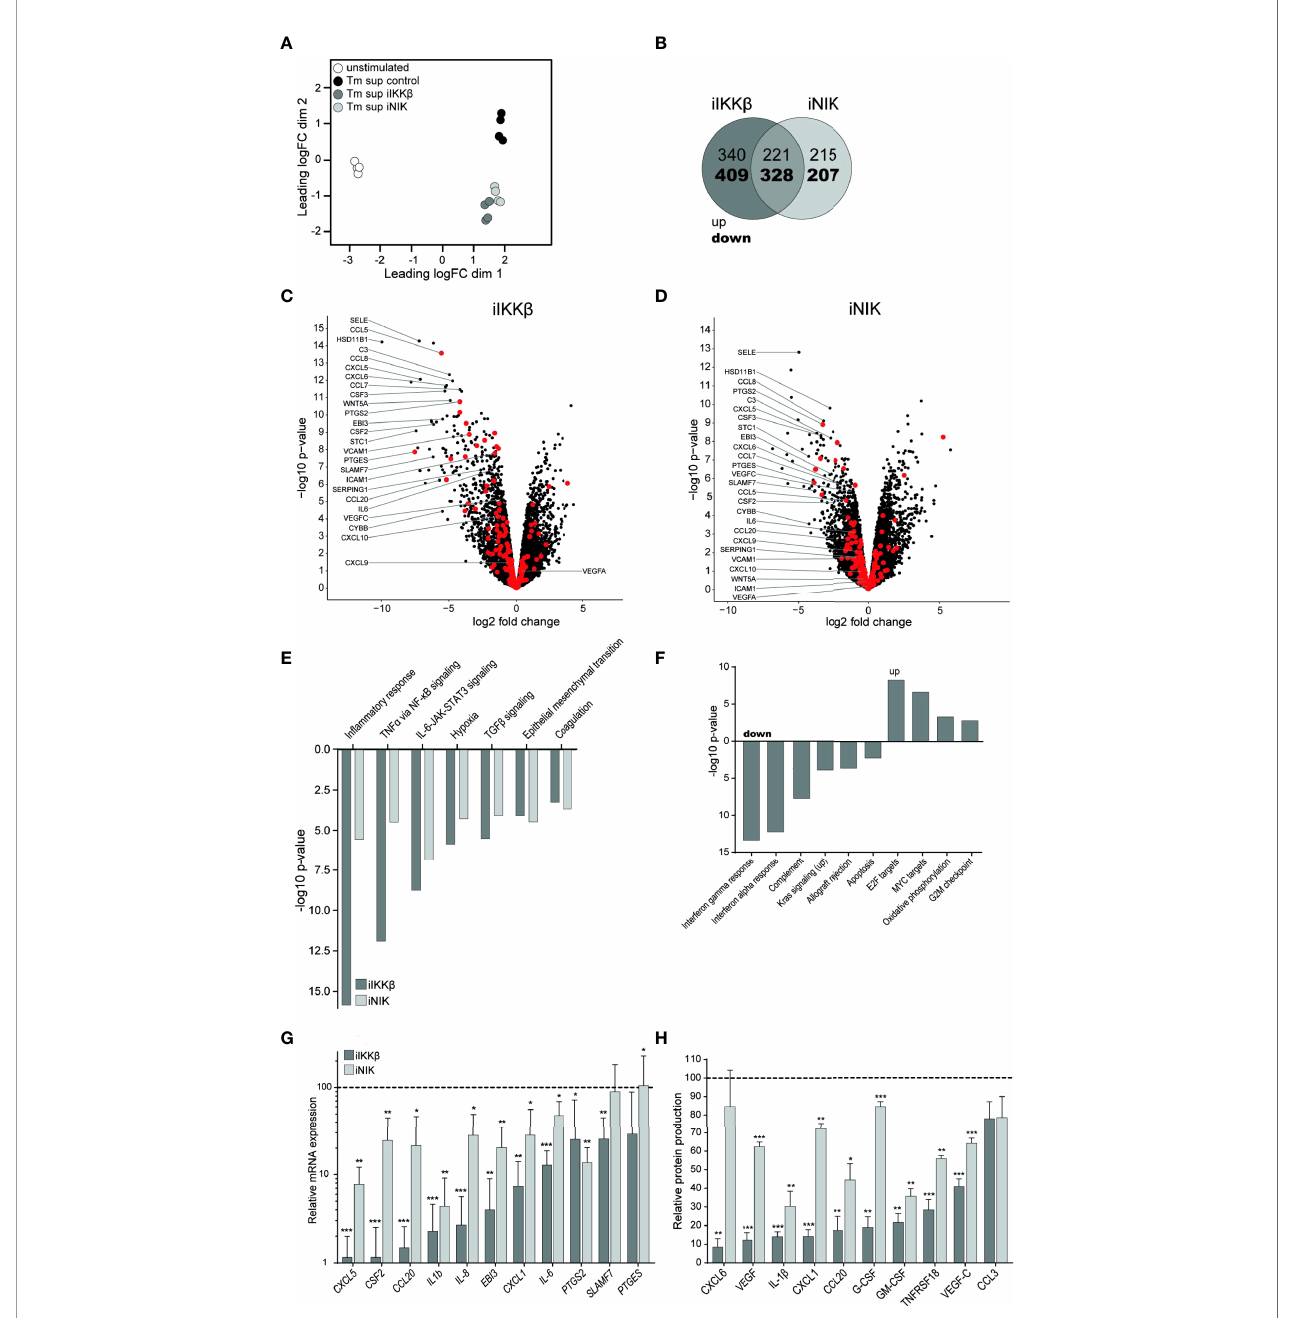
FIGURE 4 | Treatment with NF- k B inhibitors reduces EC in fl ammatory activation. RNA sequencing was performed on ECs after 72h of T m stimulation and treatment with iIKK b or iNIK. (A) Clustering of different RNA sequencing conditions. Multi-dimensional scaling of transcriptomes based on top 500 genes in unstimulated (white), T m stimulated DMSO treated (control, black), T m stimulated 1.0 µM iIKK b treated (dark gray) and T m stimulated 2.5 µM iNIK treated (light gray) ECs ( n= 4). Each dot represents an individual sample. (B) Number of genes differentially expressed in T m sup stimulated ECs treated with iIKK b (dark gray), iNIK (light gray) or both (pink) compared to control (log2 fold change>1.0, p <0.05). (C, D) Volcano plot showing changes in gene expression in (C) T m stimulated iIKK b treated vs T m stimulated DMSO treated (control) ECs and (D) T m stimulated iNIK treated vs control ECs. Enrichment (x-axis, log2 fold change) is plotted against signi fi cance (y-axis, -log10 p -value). Selected genes are annotated and NF- k B associated genes are highlighted in red. (E, F) Analysis of Hallmark gene sets. (E) Differentially expressed (FDR ≤ 0.05, p<0.05) Hallmark gene sets in both T m stimulated iIKK b treated and iNIK treated ECs vs control ECs. (F) Hallmark gene sets exclusively affected in T m sup stimulated iIKK b treated ECs vs control ECs (FDR ≤ 0.05, p<0.05). For MYC targets, Hallmark gene set MYC targets V2 is shown, similar results were obtained for MYC targets V1 . RNA sequencing results were validated on a selection of pro-in fl ammatory cytokines, chemokines, growth factors and other in fl ammatory mediators on (G) mRNA level by qPCR and (H) protein level by Magnetic Luminex assay ( n= 5). Dark gray; iIKK b , light gray; iNIK. Values are shown relative to control (dashed line). *p < 0.05, **p < 0.01, ***p <